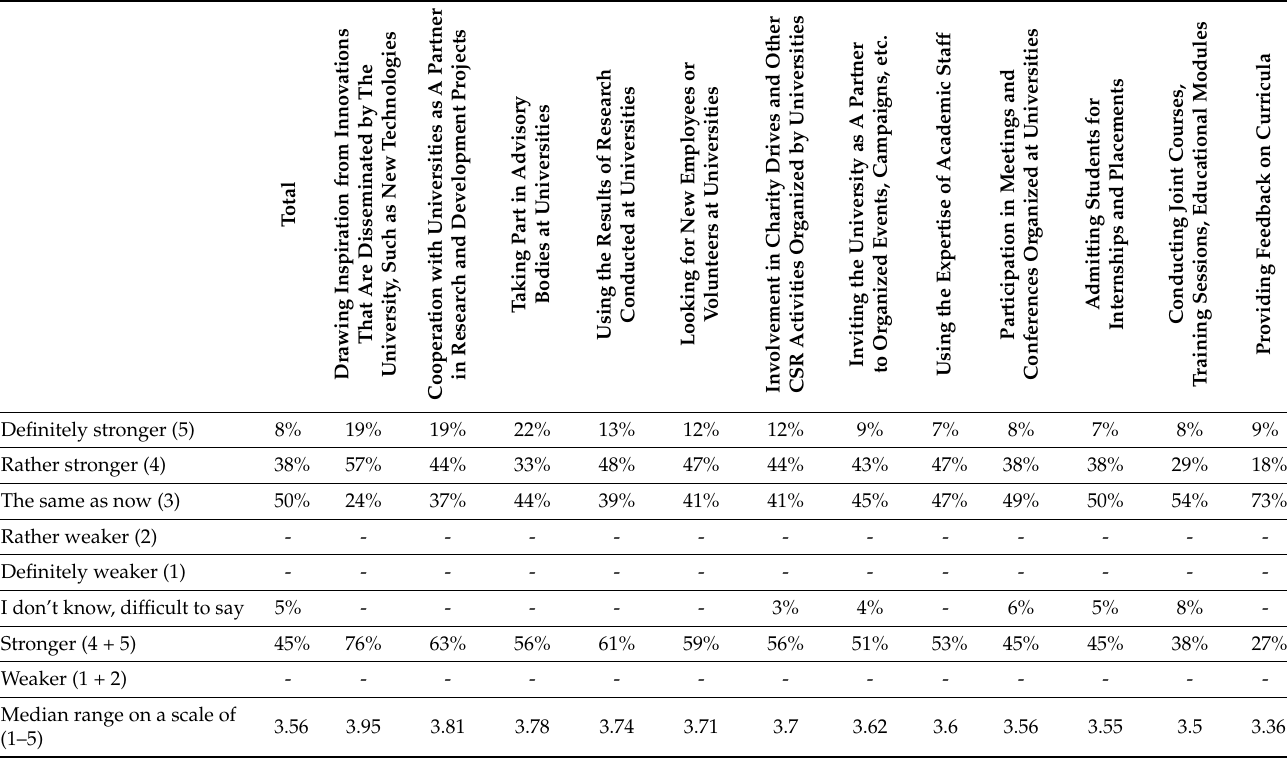
Table 3. Desired relationships between institutions and HEIs according to representatives of local governments in the upcoming